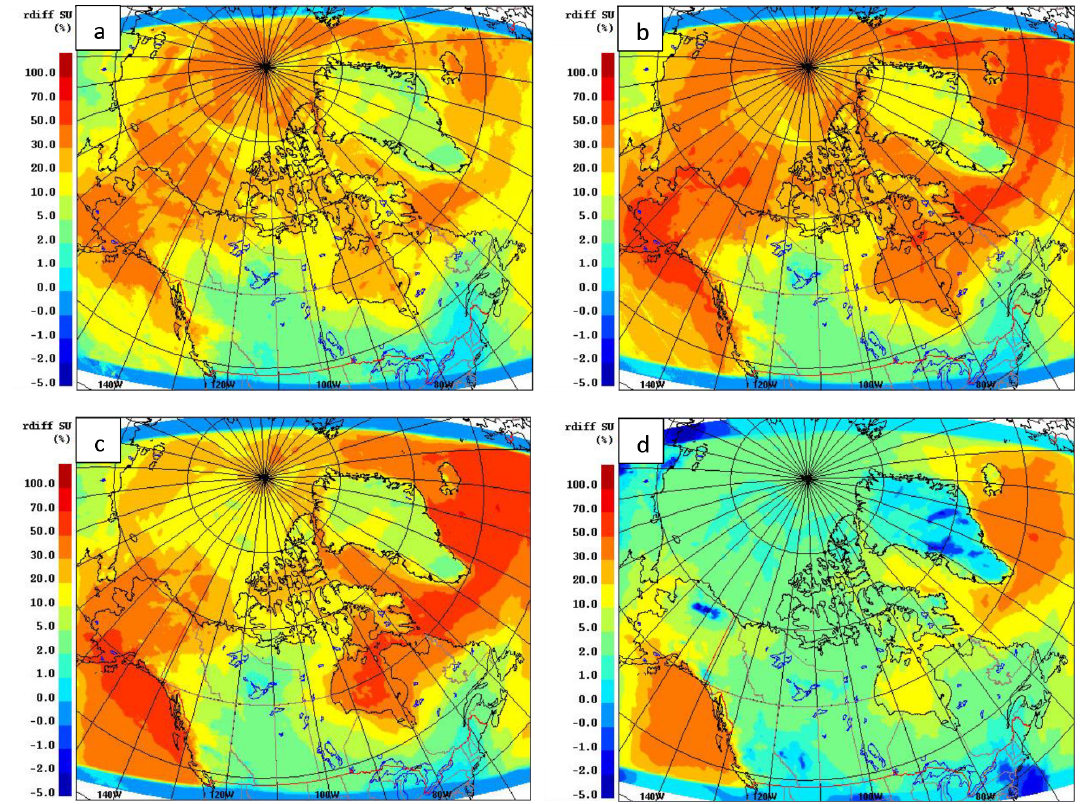
Figure 14. The relative mass change of aerosol in the (a) 10–50nm, (b) 50–100nm, (c) 100–200nm and (d) 200nm–1µm size ranges, with and without DMS(g) during July